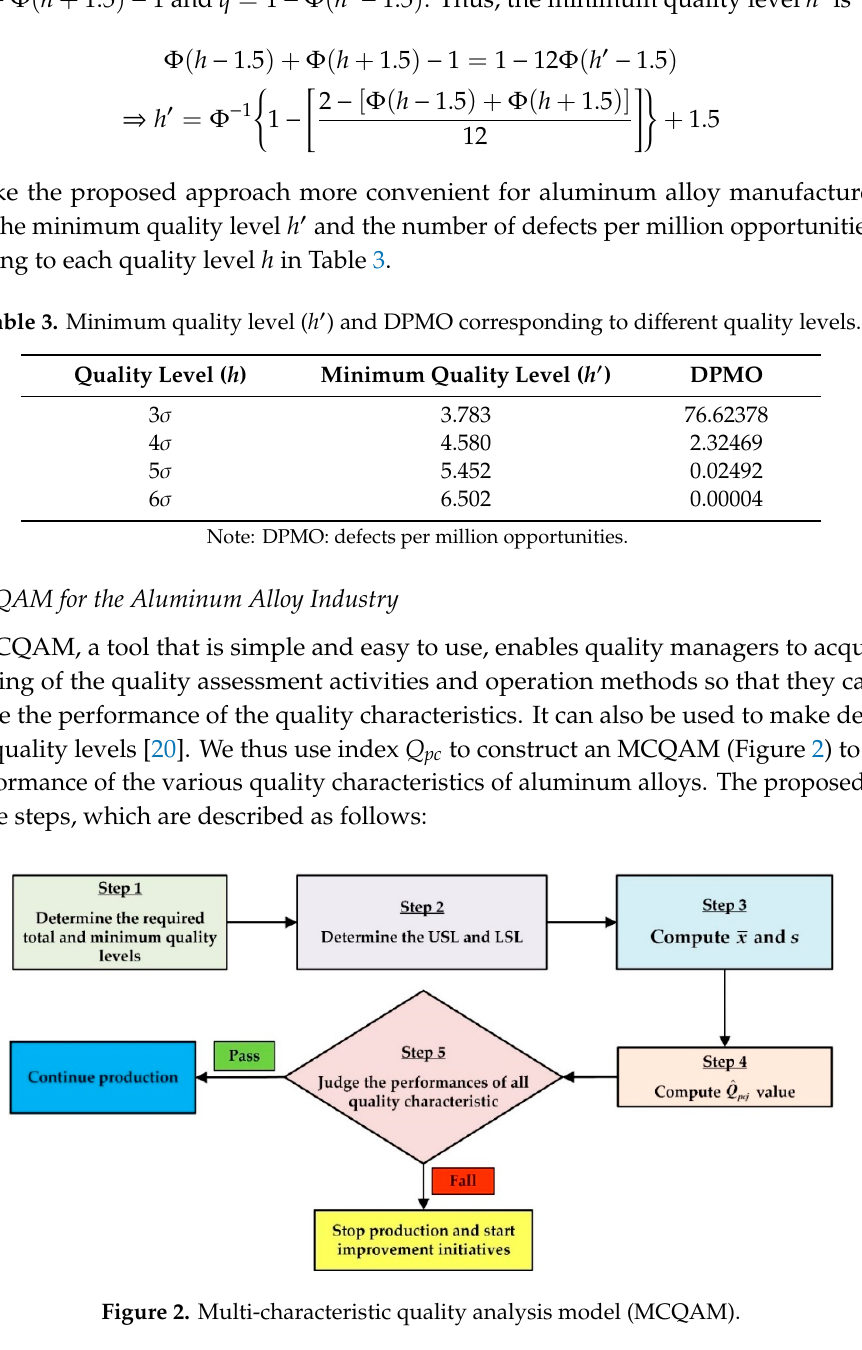
′ ) and DPMO corresponding to different quality levels.